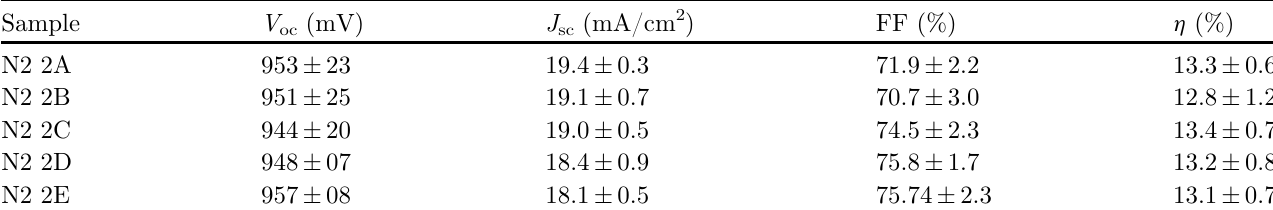
Table 3. Average performance of perovskite solar cells fabricated by USSC and high pressure gas quenching, with 0.5 M solution (with standard deviation).